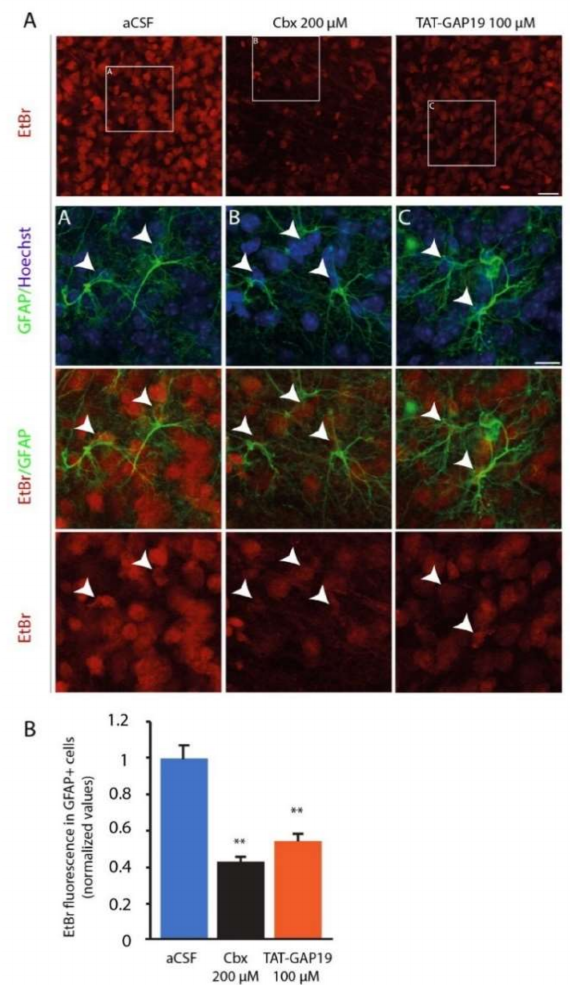
Figure 4. ( A ): Representative images depicting ethidium bromide (EtBr) uptake via hemichannels in hypothalamic (ARC) slices treated with either artificial cerebrospinal fluid (aCSF), 200 µ M carbenoxolone (Cbx) or 100 µ M the connexin-43 (Cx43) hemichannel blocker TAT-GAP19 for 15 min, then exposed to EtBr for 10 min. After fixation, slices were submitted to Glial Fibrillary Acidic Protein (GFAP) immunostaining and Hoechst labelling. Scale bar: 15 µ m. ( B ): Quantification of EtBr fluorescence measured in GFAP + astrocytes. n = 5, with each n representing the average of three replicates. ** p <